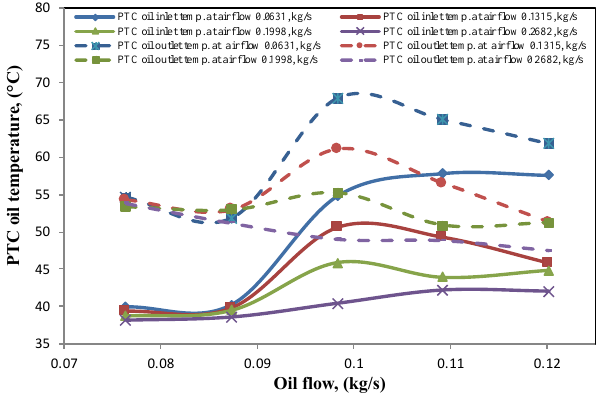
Figure 22. Average PTC oil temperature at different air and oil flow rates.